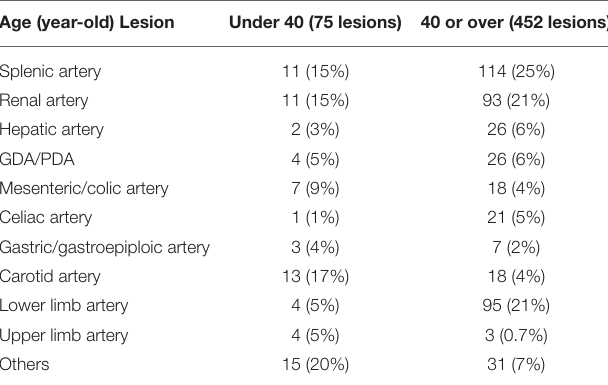
TABLE 2 | Comparison of the lesions between the two groups. Age (year-old) Lesion